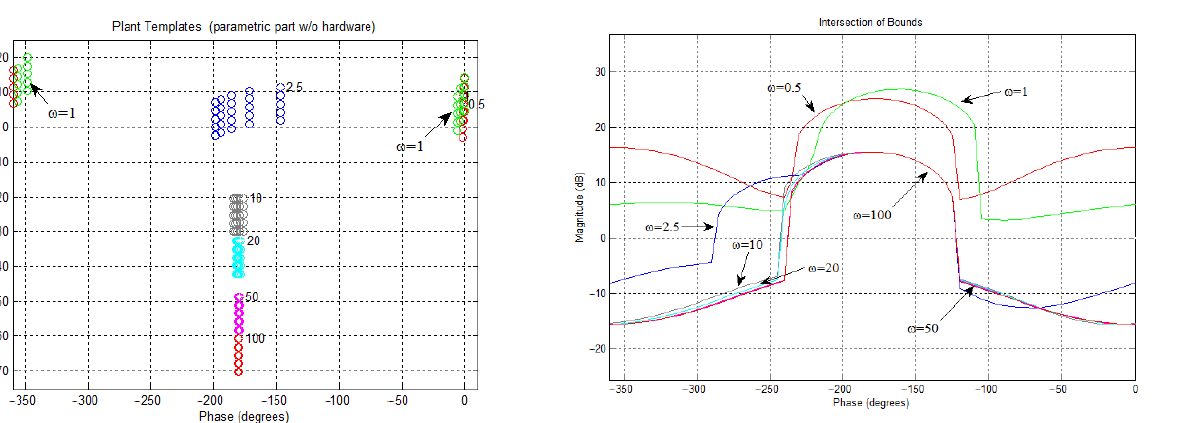
Figure 12. The intersection of bounds for the vertical plane